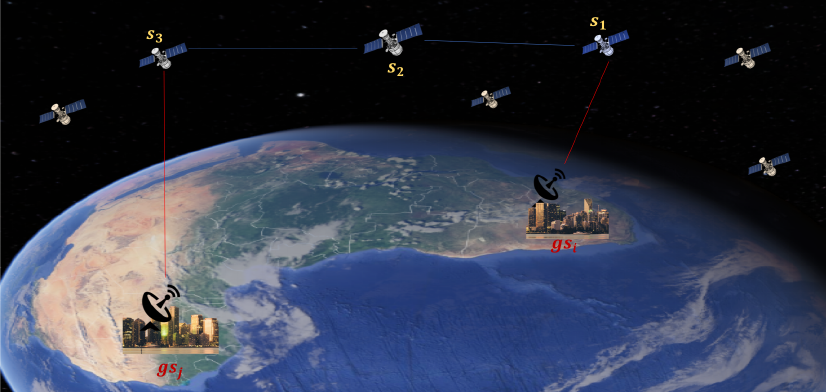
Figure 1. Ground station satellite communication illustration. This Figure demonstrates communica- tion between 2 ground stations: gs i , gs j via 3 satellites: s 1 , s 2 , s 3